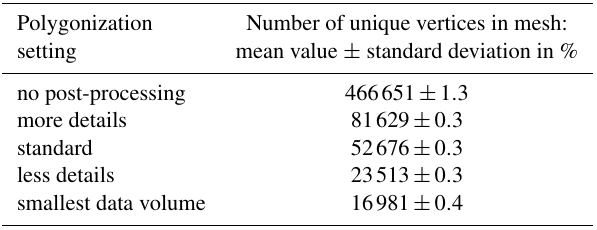
Table 3. Statistical overview of the number of vertices of the dif- ferent triangle meshes for measurement series ID W . The number of vertices (sampling points SP k ) of the used reference geometry is 1930759.